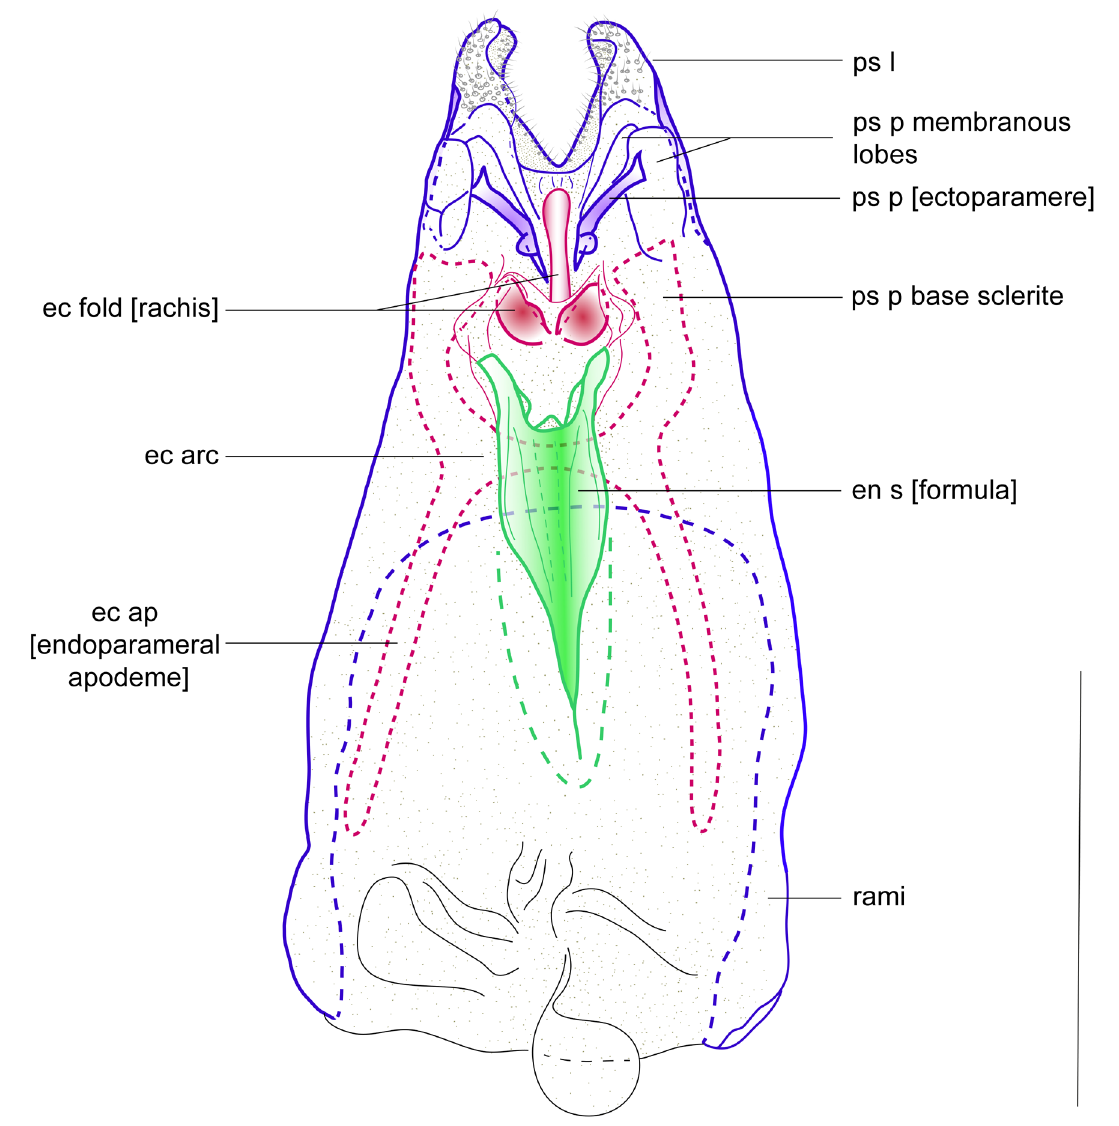
Fig. 4. Drawing of male genitalia of N. malaya Robillard & Tan sp. nov. (with labels of parts).